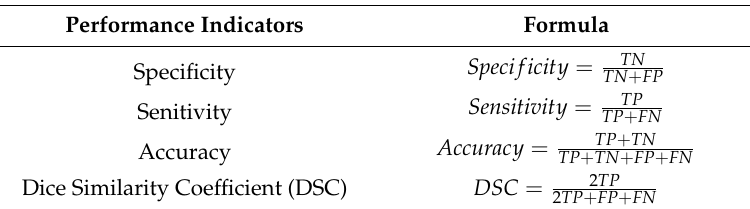
Figure 10. Confusion matrices in case of PH 2 database (Me – melanoma, Cn – common nevus): ( a ) Validation phase; ( b ) Testing phase. Table 2. Expressions for the performance